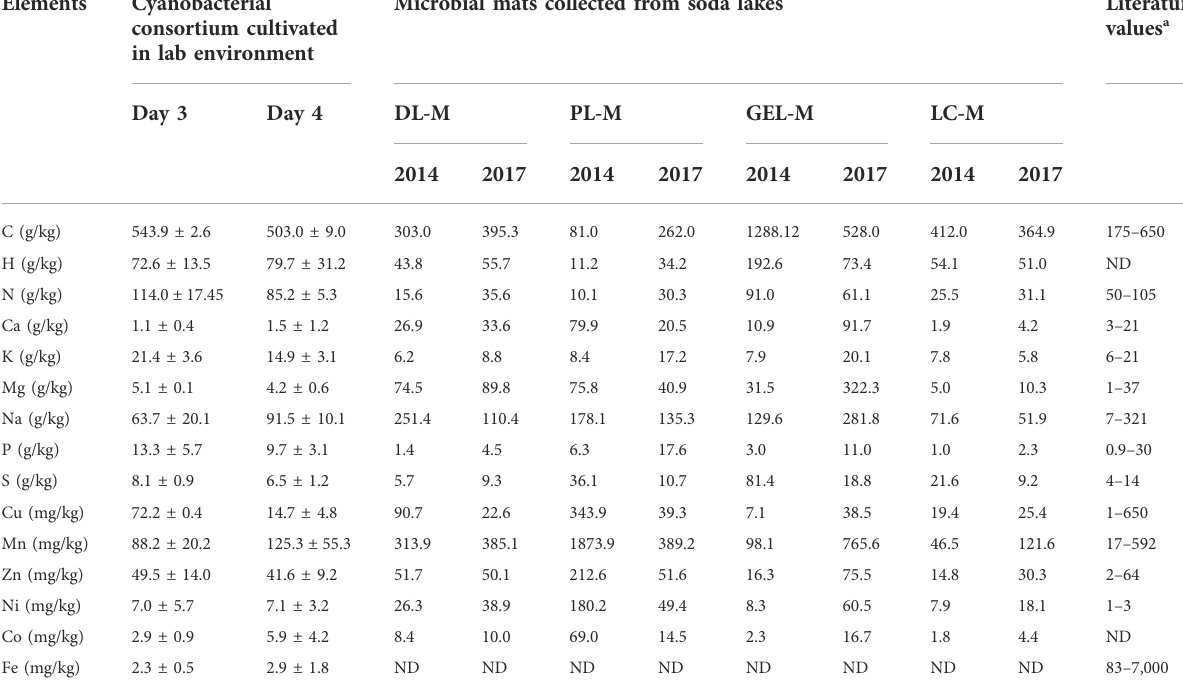
TABLE 2 Comparison between elements in cultivated cyanobacteria consortium, microbial mats from soda lakes (Cariboo Plateau, British Columbia) and literature values. Elements Cyanobacterial Microbial mats collected from soda lakes consortium cultivated in lab environment